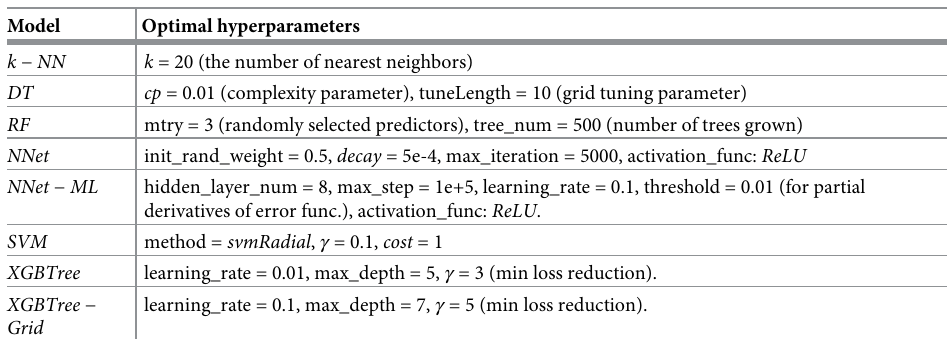
Table 2. Optimal hyperparameters of the